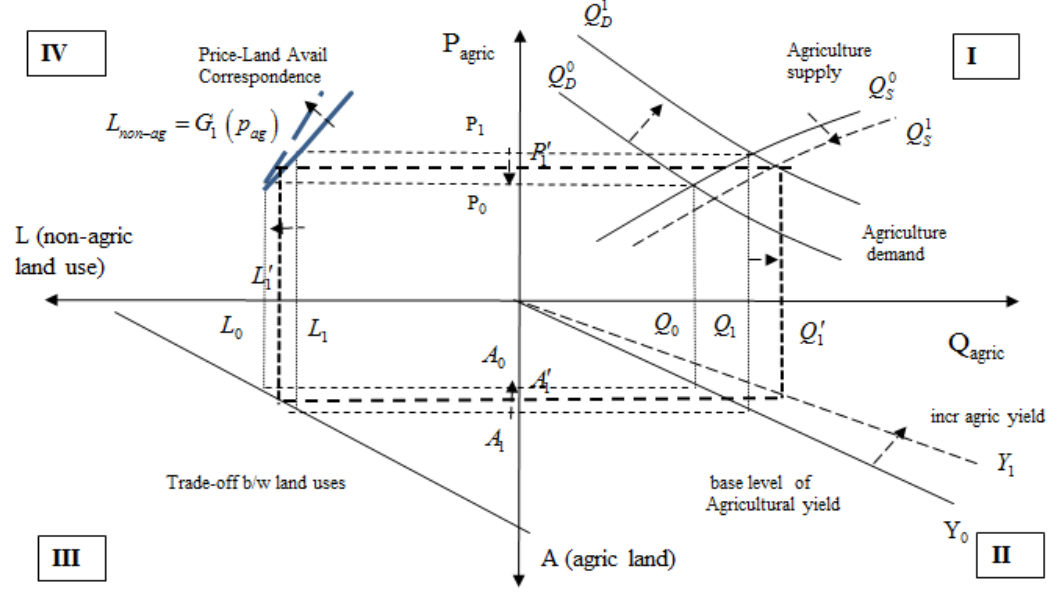
Figure 2. Linkages between biofuel-driven market shifts and agricultural land use with price-induced productivity